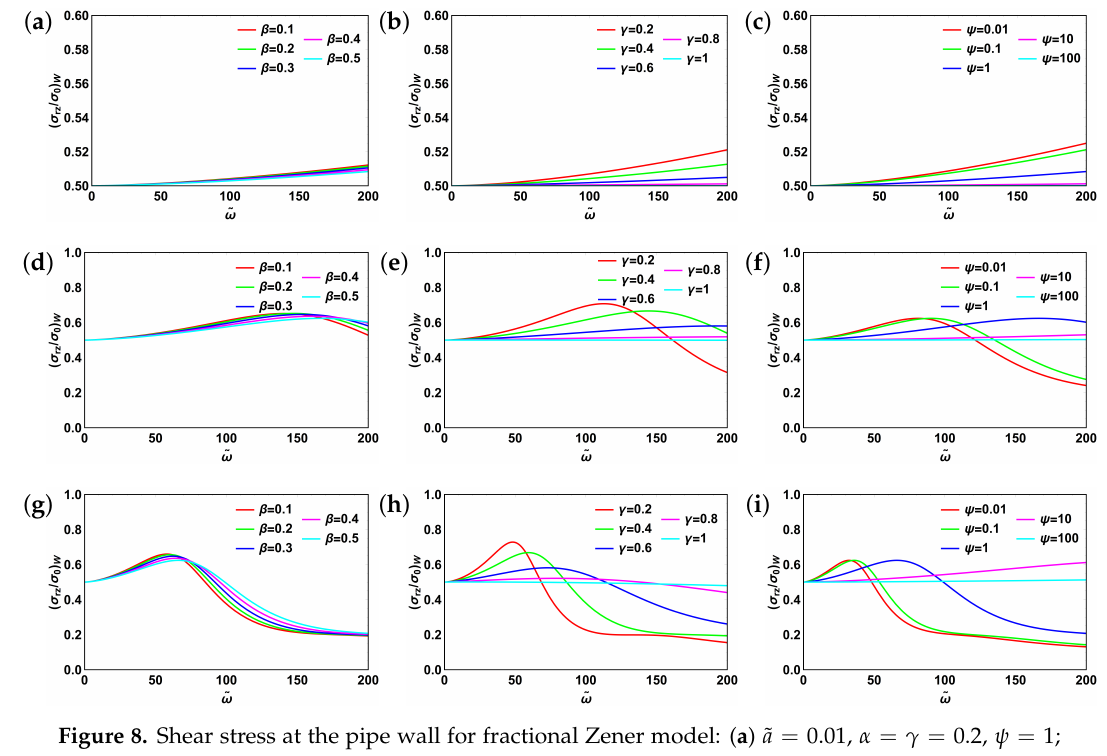
Figure 8. Shear stress at the pipe wall for fractional Zener model: ( a ) ˜ a = 0.01, α = γ = 0.2, ψ = 1; ( b ) ˜ a = 0.01, α = β = 0.5, ψ = 1; ( c ) ˜ a = 0.01, α = β = γ = 0.5; ( d ) ˜ a = 0.05, α = γ = 0.2, ψ = 1; ( e ) ˜ a = 0.05, α = β = 0.5, ψ = 1; ( f ) ˜ a = 0.05, α = β = γ = 0.5; ( g ) ˜ a = 0.1, α = γ = 0.2, ψ = 1; ( h ) ˜ a = 0.1, α = β = 0.5, ψ = 1; ( i ) ˜ a = 0.1, α = β = γ = 0.5. Subscript “w” stands for